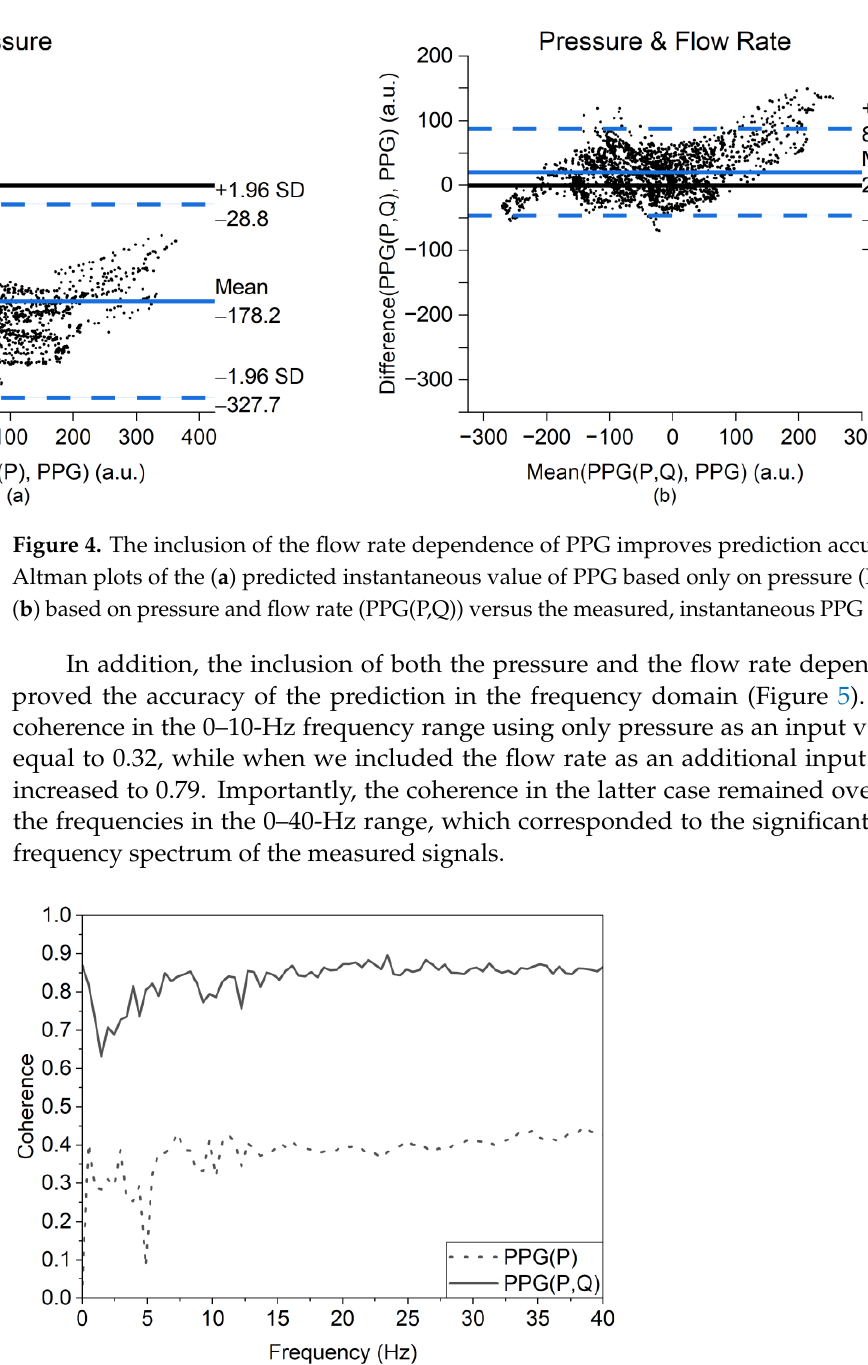
Figure 5. Improved prediction of the PPG signal in the frequency domain. Magnitude-squared coherence of the measured PPG signal and the predicted value of PPG based only on pressure (PPG(P)) or based on pressure and flow rate (PPG(P,Q)).